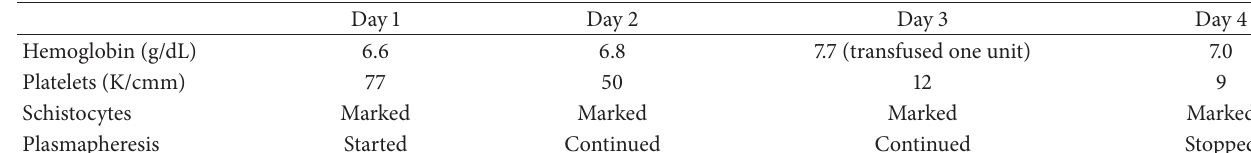
Table 1: Schematic representation of hemoglobin, platelets, schistocytes, and plasmapheresis.